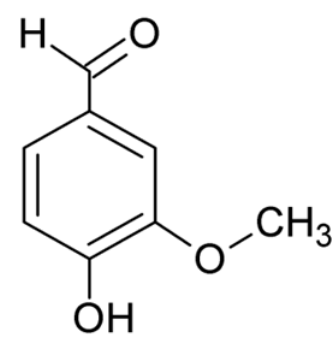
Figure 1. Vanillin